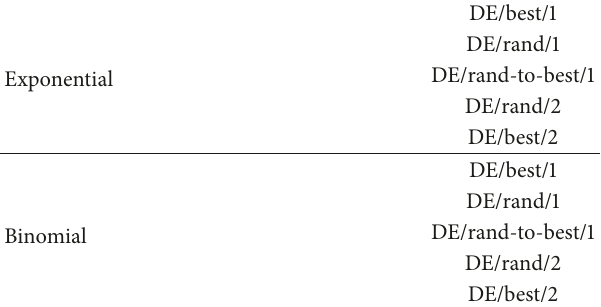
Table 5: Strategies of